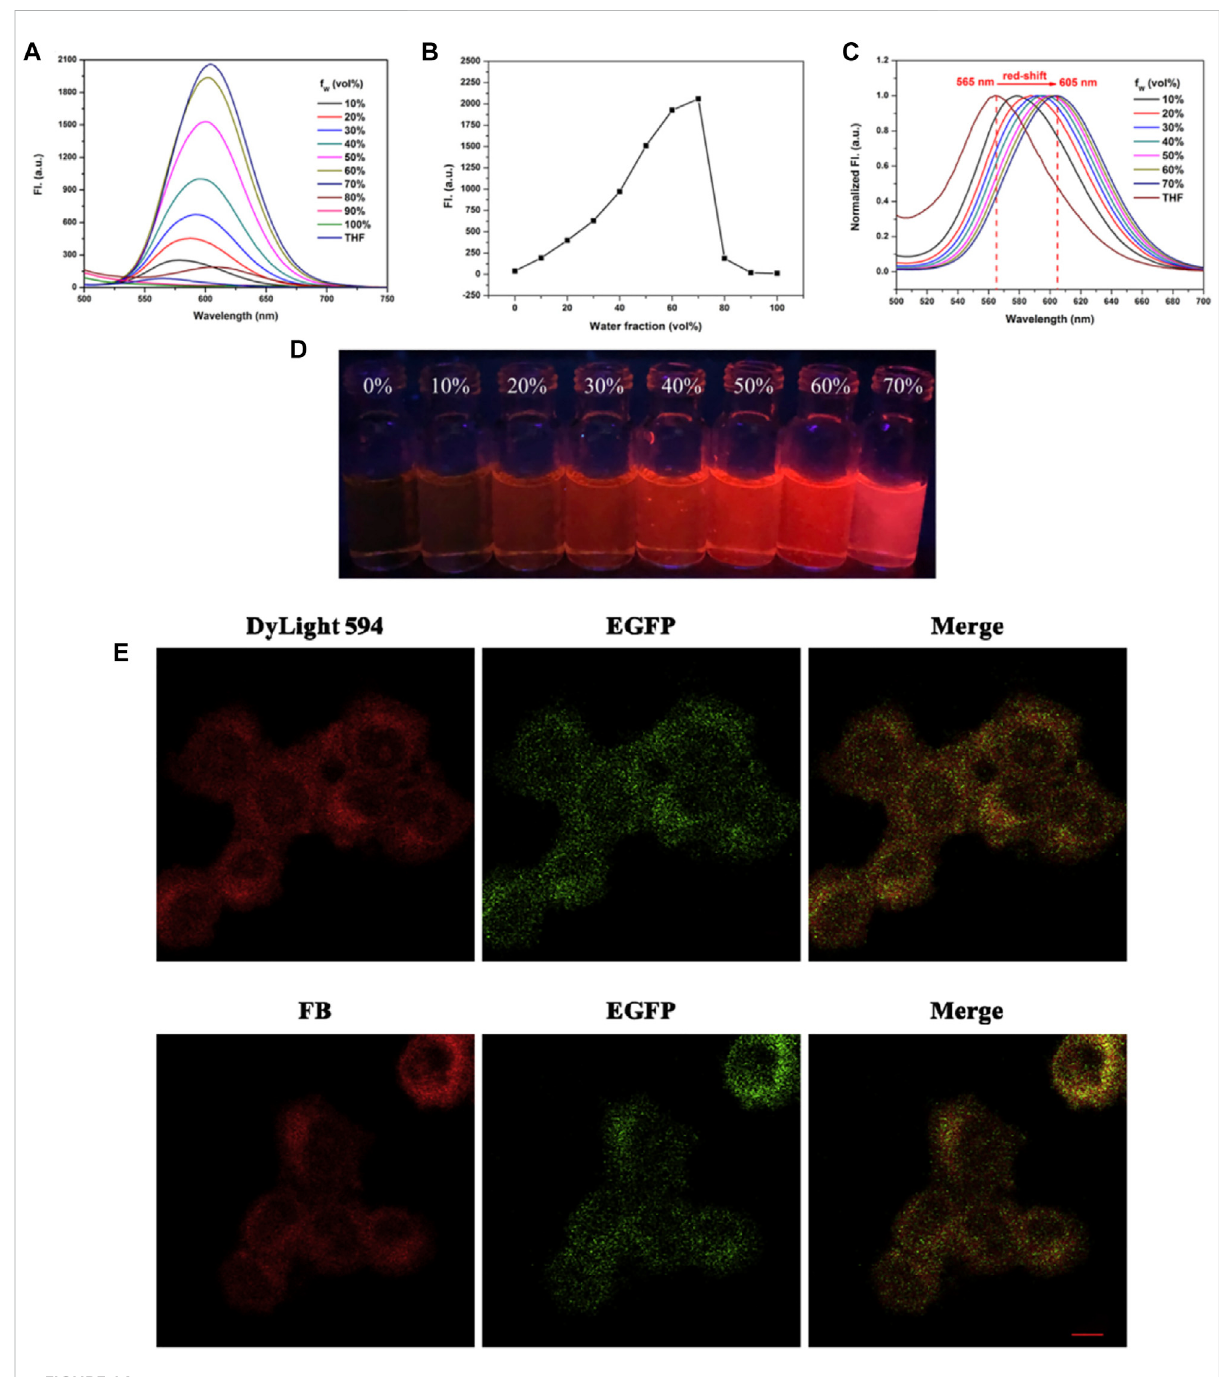
FIGURE 14 AIE characteristic study of the probe FB. (A) Fluorescence spectrum of the probe FB in THF-H 2 O solution. (B) Fluorescence intensity of the probe FB at 605 nm in various water fractions. (C) Normalized fl uorescence spectrum of the probe FB in THF-H 2 O solution. (D) Photographs of